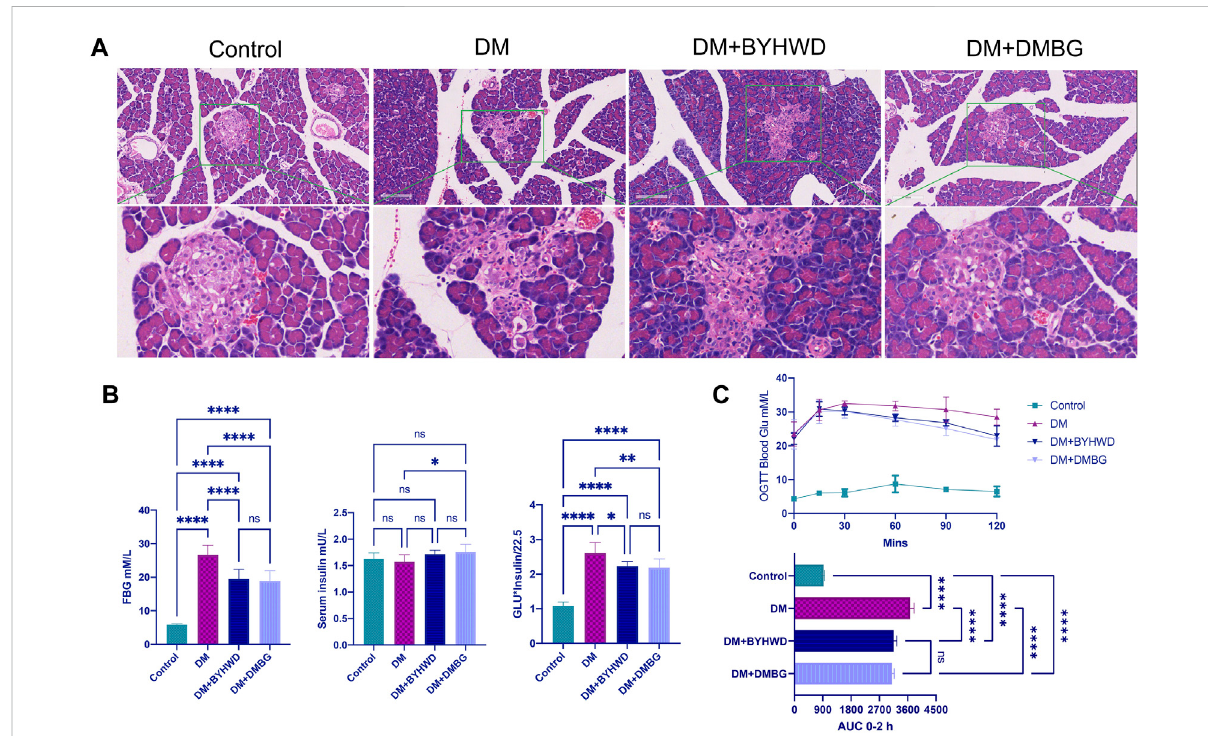
FIGURE 2 BYHWD maintained the normal structure of the islet and adjusted the abnormal glucose metabolism induced by HFD in ZDF rats: (A) representativeHE imagesoftherat pancreasfrom differentgroups; (B) thecomparison of theblood glucose, serum insulin,and the HOMA-IR index among four groups at the end of the treatments; (C) the comparison of the results of the OGTT among the four groups during the experimental period. Data are shown as means ± S.D ( n = 6 – 8). Statistical analysis was performed using one-way ANOVA, followed by Tukey ’ s